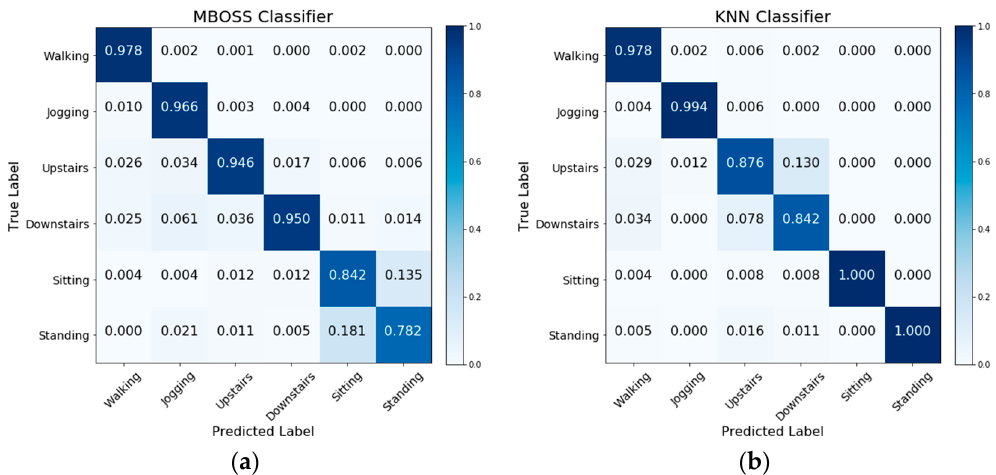
Sensors 2019 , 19 FOR PEER REVIEW Figure 6. Accuracy results for all classifiers evaluated based on personalized model.